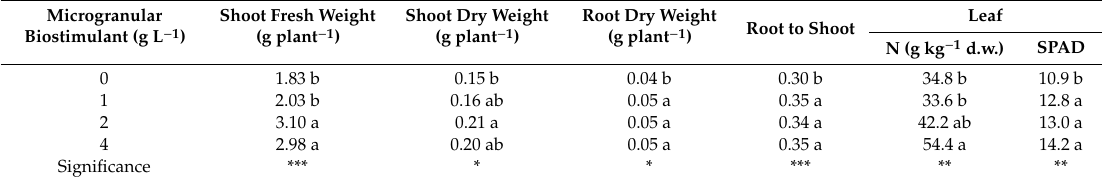
Table 1. E ff ect of biostimulant treatments on dry weight of shoots and roots, root to shoot ratio and nitrogen content, and Soil-Plant Analysis Development (SPAD) index of leaves in lettuce transplants (Experiment 1).